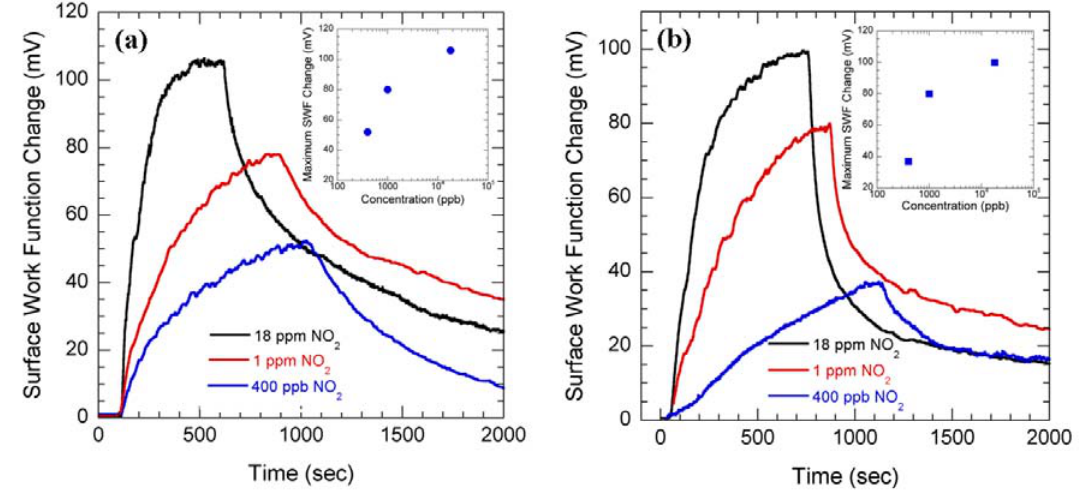
Figure 4: SWF changes of (a) SnO flow was switched on and off. Insets show maximum SWF changes plotted against the concentration of NO